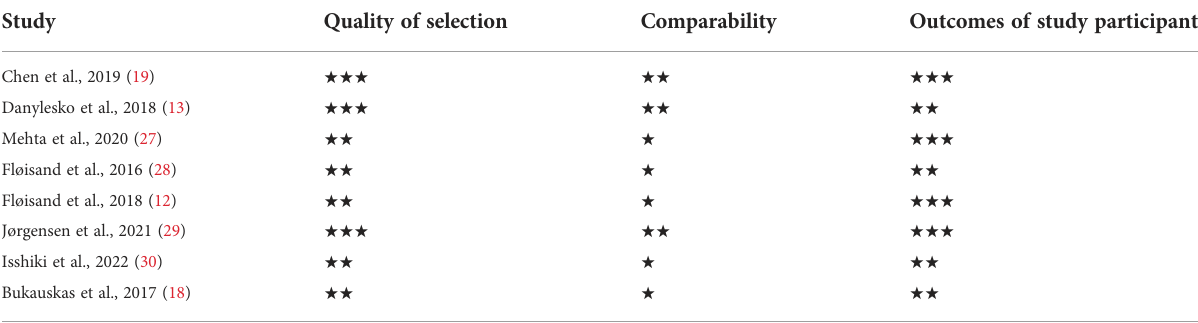
TABLE 2 Quality assessment of the included